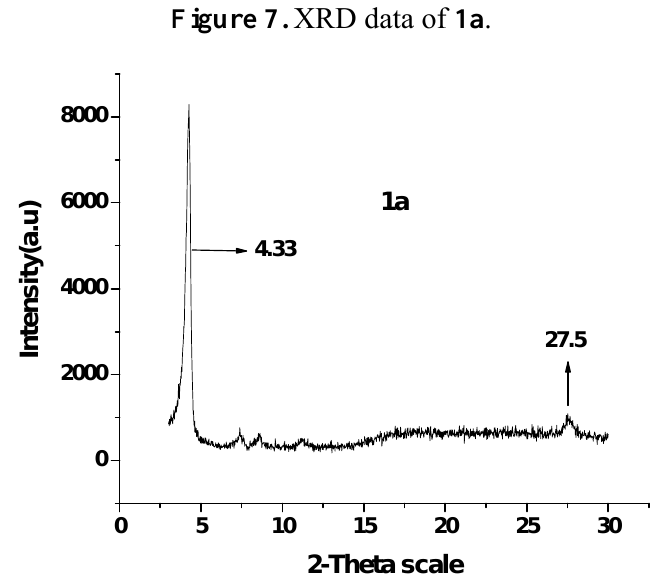
Figure 7. XRD data of 1a .